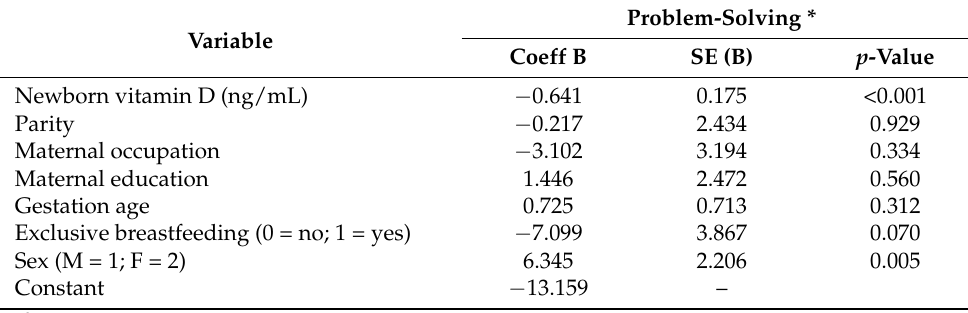
Table 6. Factors affecting decreased problem-solving domain using regression